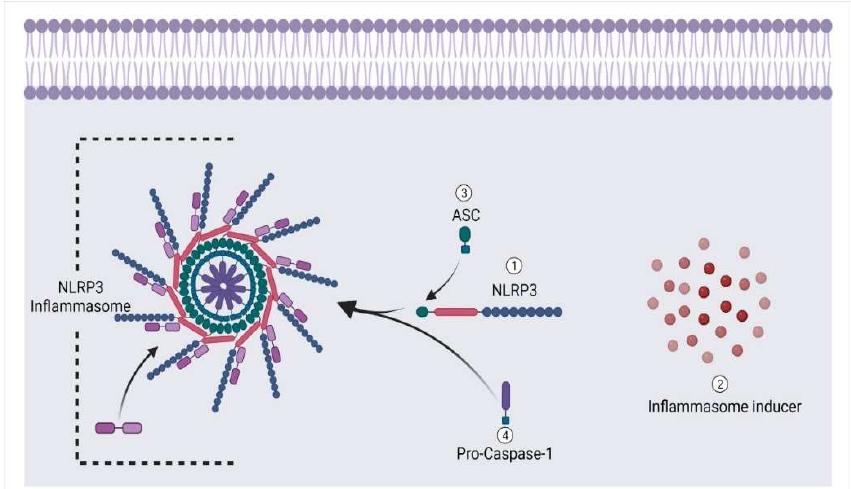
Figure 8. Formation of NLRP3 base inflammasome under the influence of cell damage.